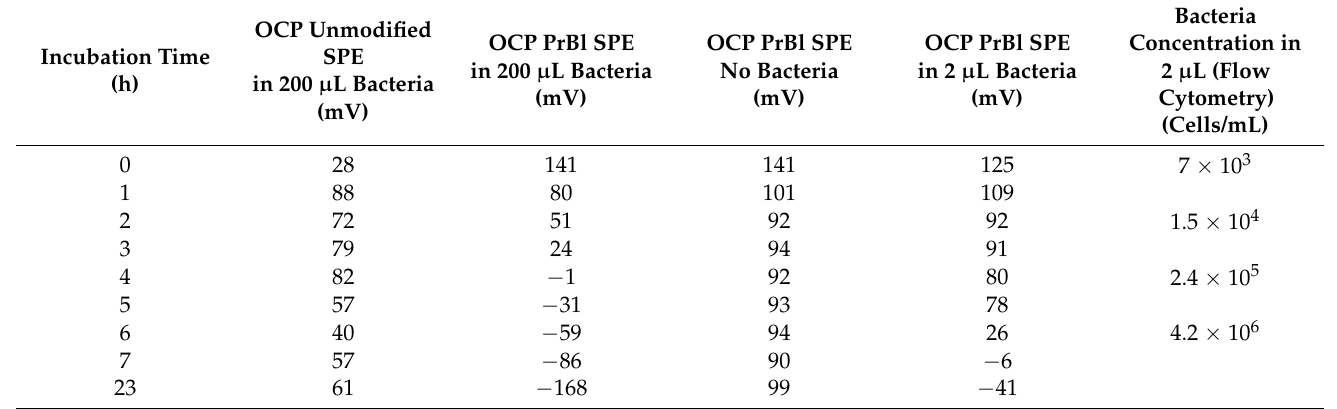
Table 2. Incubation time vs. OCP in AUM, comparing PrBl-modified and unmodified SPEs at different concentrations of